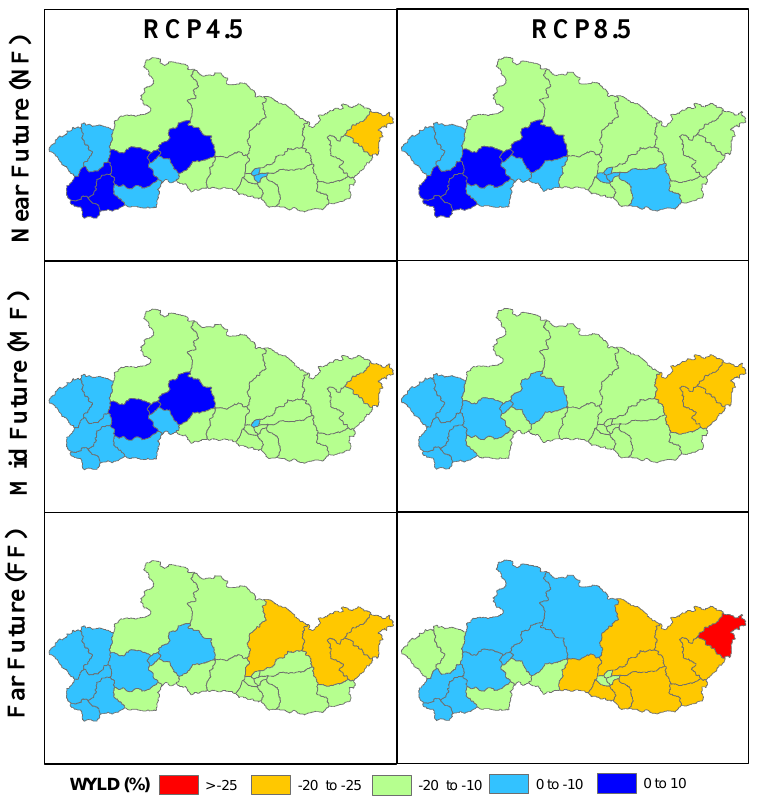
Figure 12. Changes in the water yield (WYLD) measured in % unit of each sub-basin in the Thuli River Basin with respect to Baseline period for Near Future (NF), Mid Future (MF), and Far Future (FF) under RCP 4.5 and RCP 8.5.